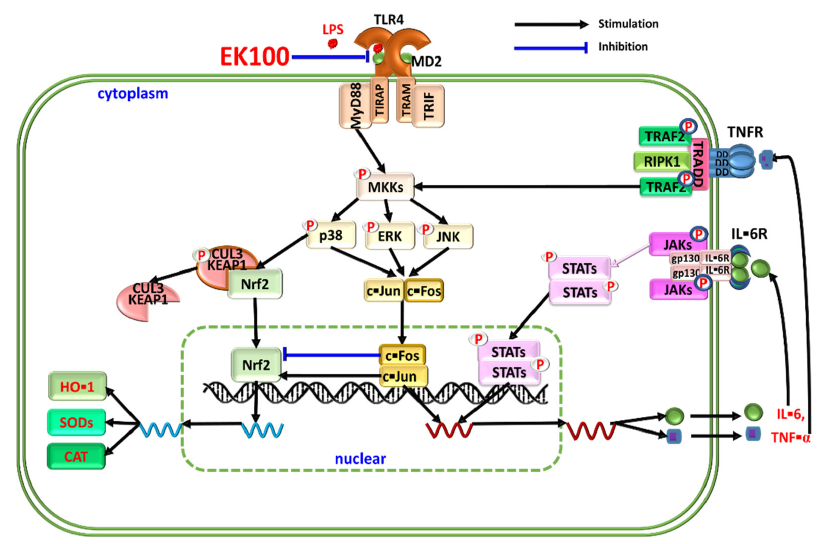
Figure 7. The suggested mechanism relating to the effect of EK100 attenuates inflammatory responses by inhibiting LPS/TLR4 signaling relative MAPK/AP-1 signaling-induced IL-6/JAK/STAT signaling pathway and activating the Nrf2/HO-1 antioxidative signaling pathway in murine macrophage-like RAW 264.7 cells in vitro .